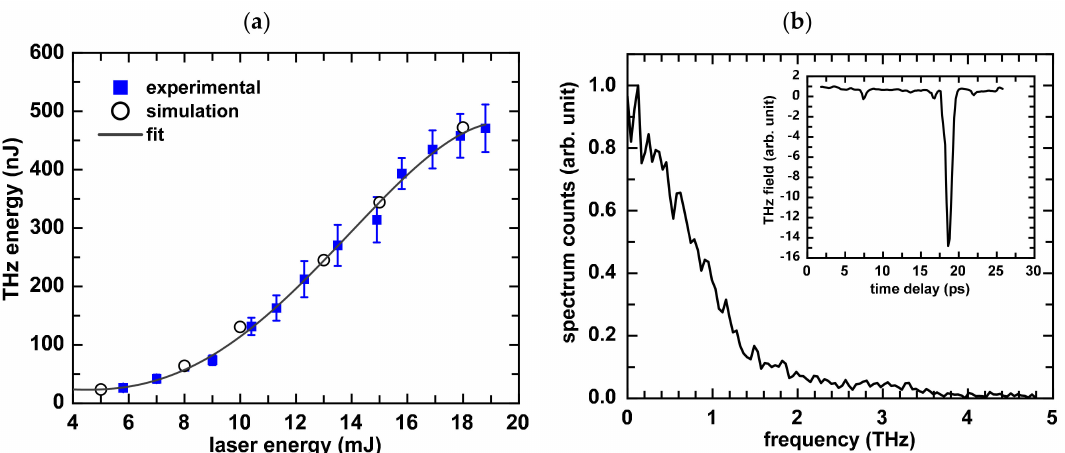
Figure 8. ( a ) Measured THz pulse energy as a function of the laser energy (before frequency doubling). The simulation result (open circle) is normalized to the experimental result (blue square) for comparison. ( b ) Spectrum of the THz pulse obtained from Fast-Fourier Transform (FFT) of the THz pulse in the inset, where the THz pulse was directly measured from the THz-TDS method. Note that the spectrum is limited up to a maximum frequency of ~5 THz due to the intrinsic properties of the ZnTe crystal.